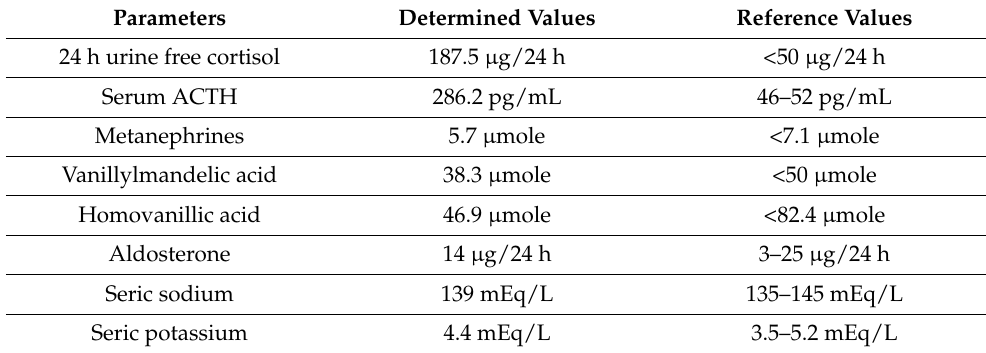
Table 1. Hormonal profile, suggestive of ectopic ACTH secretion.